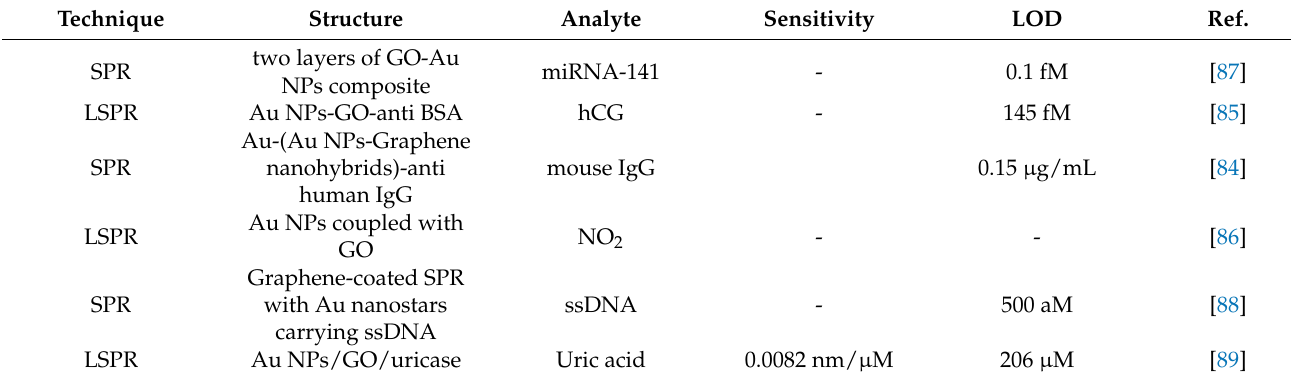
Table 5. A summary of selected papers regarding graphene-based nanoparticle coupled SPR biosensor. Technique